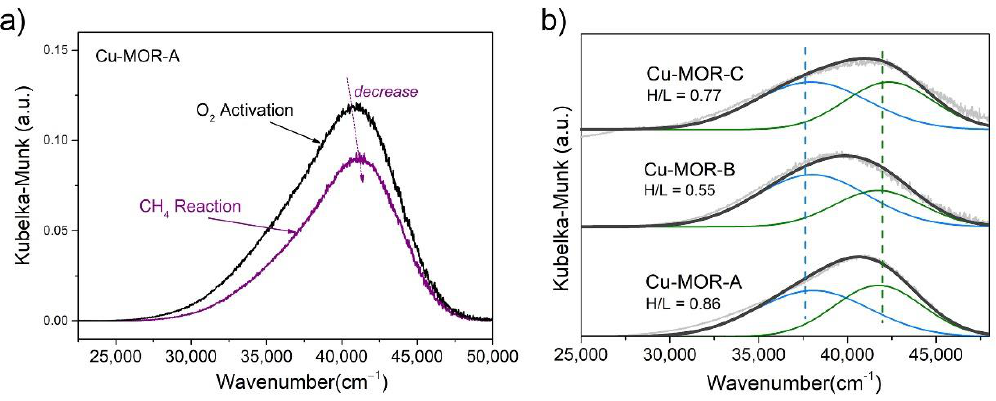
Figure 4. ( a ) In situ UV-Vis spectra of the activated Cu-MOR-A catalyst before and after the contact with methane at 473 K; ( b ) Fitting of the UV-Vis signals for the three Cu-MOR samples after O 2 activation with the area ratio of the high- wavenumber band to the low-wavenumber one (H/L) inserted. All the Cu-MOR samples used here are those with their respective threshold Cu loadings (shown in Figure 3).